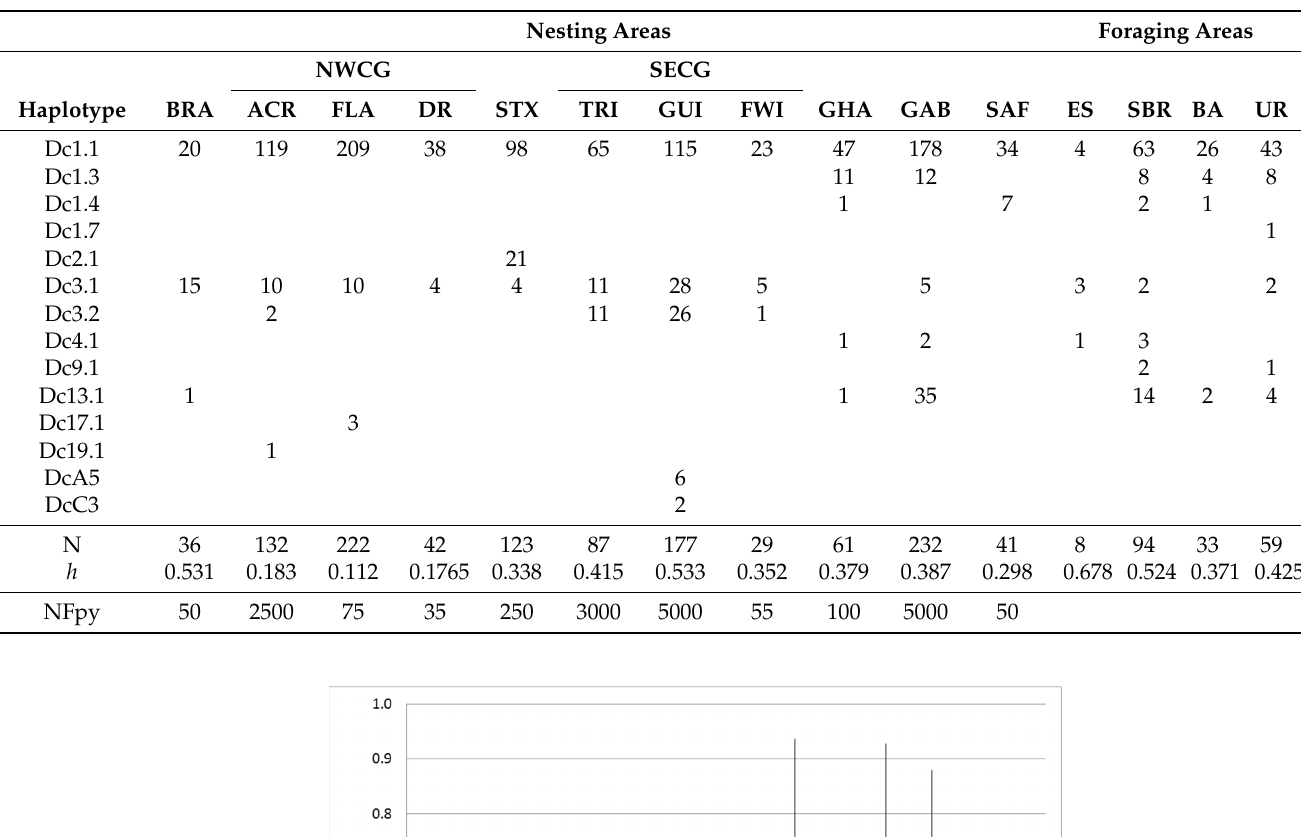
Table 1. Haplotype frequencies for Atlantic and Indian Ocean leatherback rookeries and foraging grounds, based on 763 bp mtDNA sequences. Abbreviations correspond with Figure 1. NWCG includes ACR, FLA, and DR; SECG includes TRI, GUI, and FWI (adapted from Vargas et al. [33]). Sample size (N), haplotype diversity ( h ), and estimated average number of nesting females per year (NFpy) are shown.